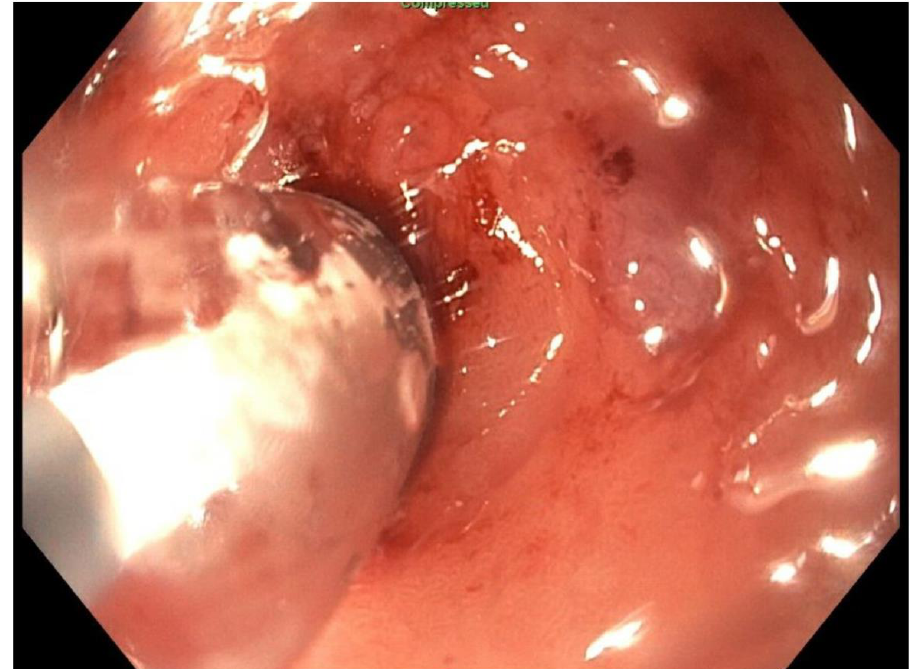
Figure 14. Balloon dilation (fluoroscopic view).